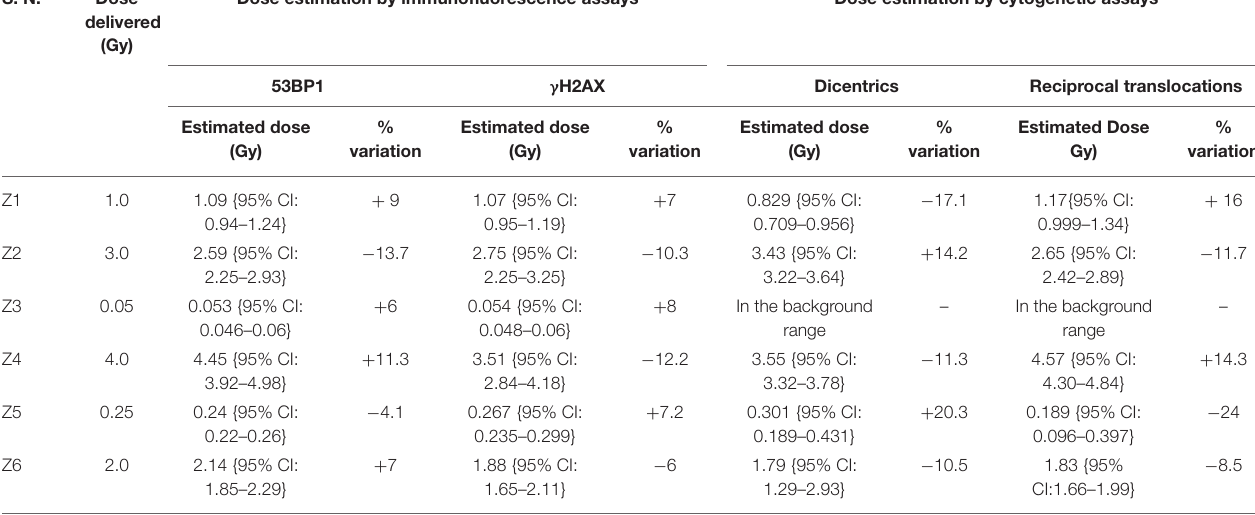
TABLE 3 | Comparative evaluation of established response curve (phospho-53BP1) by estimating biological doses of 6 dose blinded samples by phospho-53BP1, γ H2AX, dicentric, and translocation assays. S.